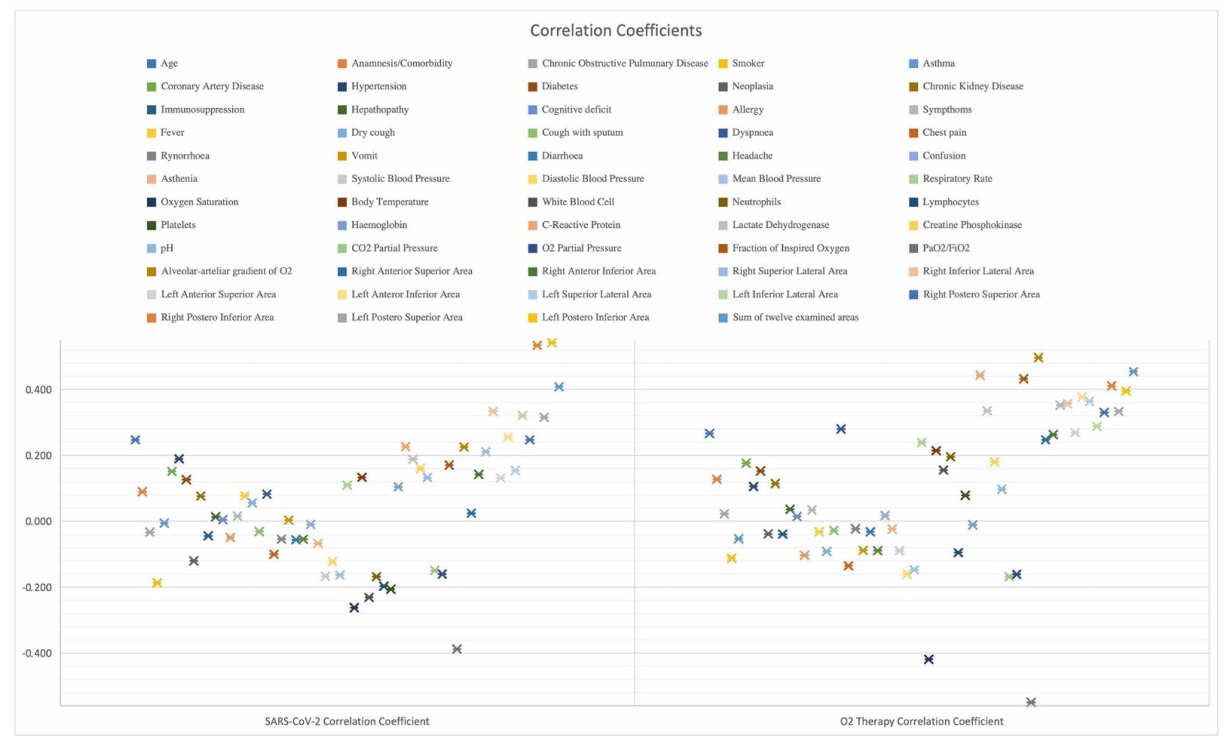
Figure 2. Examined features and their correlation with